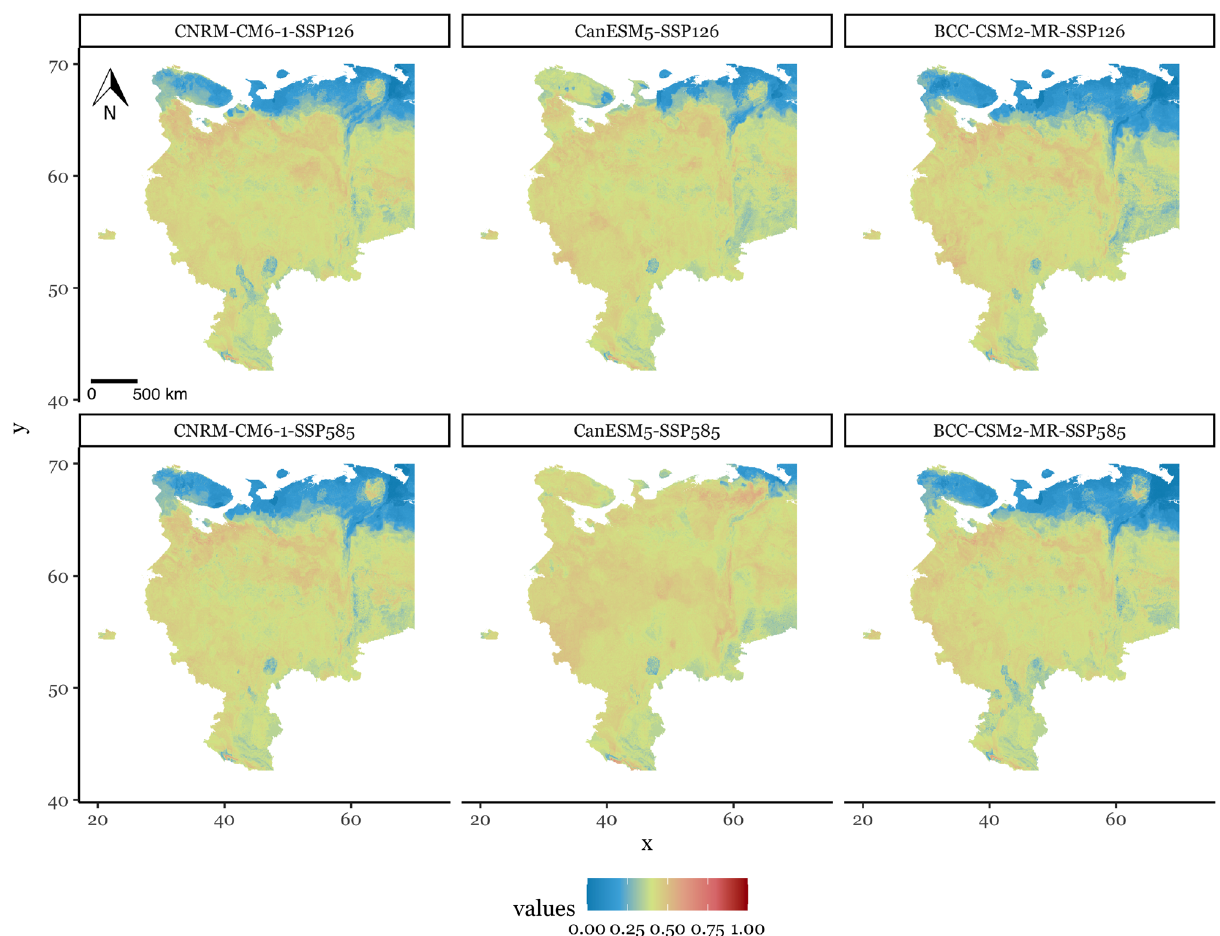
Figure 3. Maps of prediction for possible distribution in future climate conditions on the example of selected global climate models CNRM-CM6-1, CanESM5, BCC-CSM2-MR, in two scenarios of Shared Socioeconomic Pathways—SSP126 and